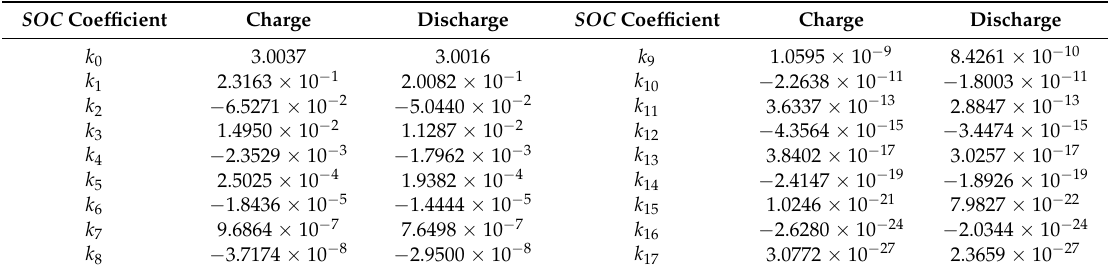
Figure 15. Comparison results of MSE s and errors of estimation at different polynomial orders: ( a ) results for charge; and ( b ) results for discharge.